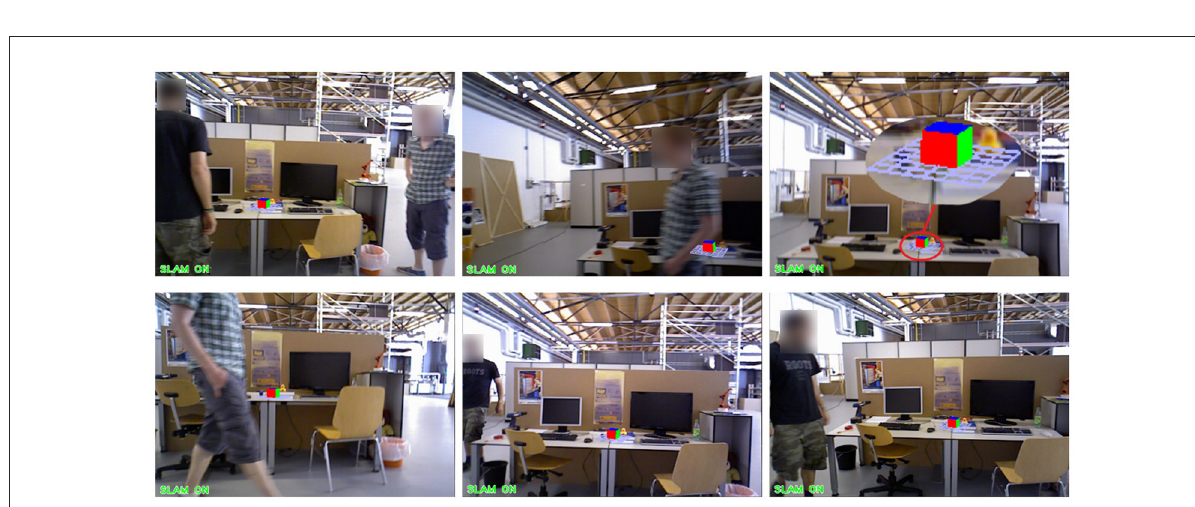
FIGURE16 The application effect of our method in the augmented reality